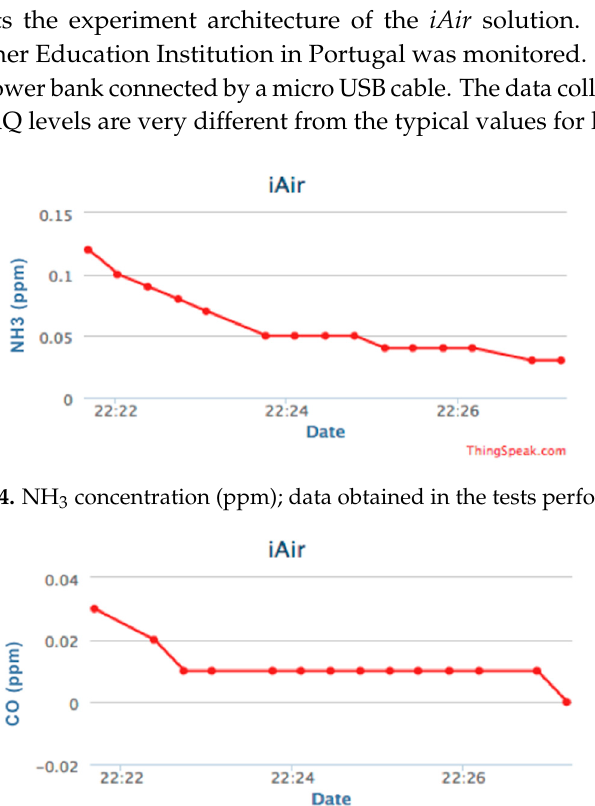
Figure 6. C 3 H 8 concentration (ppm); data obtained in the tests performed.